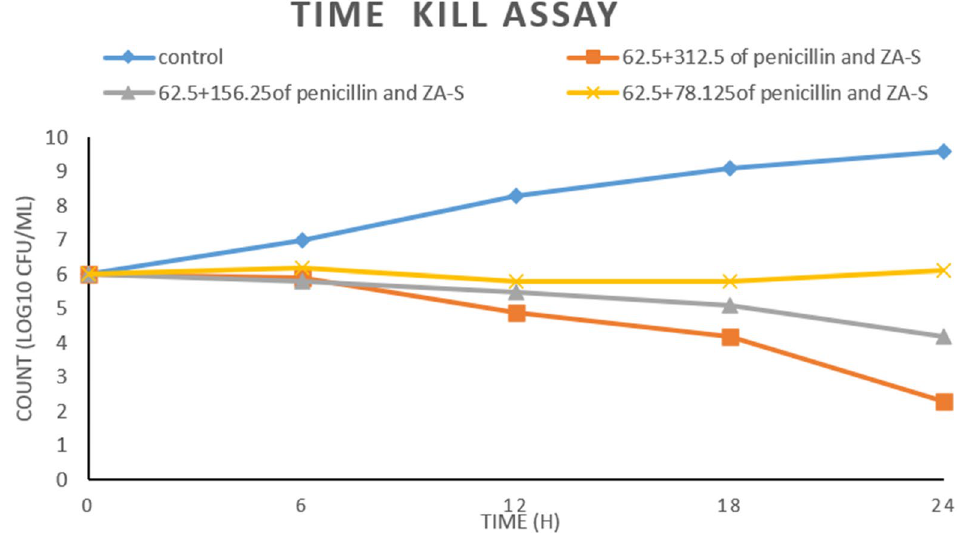
acid‑28‑O‑[β‑D‑glucopyranosyl] ester